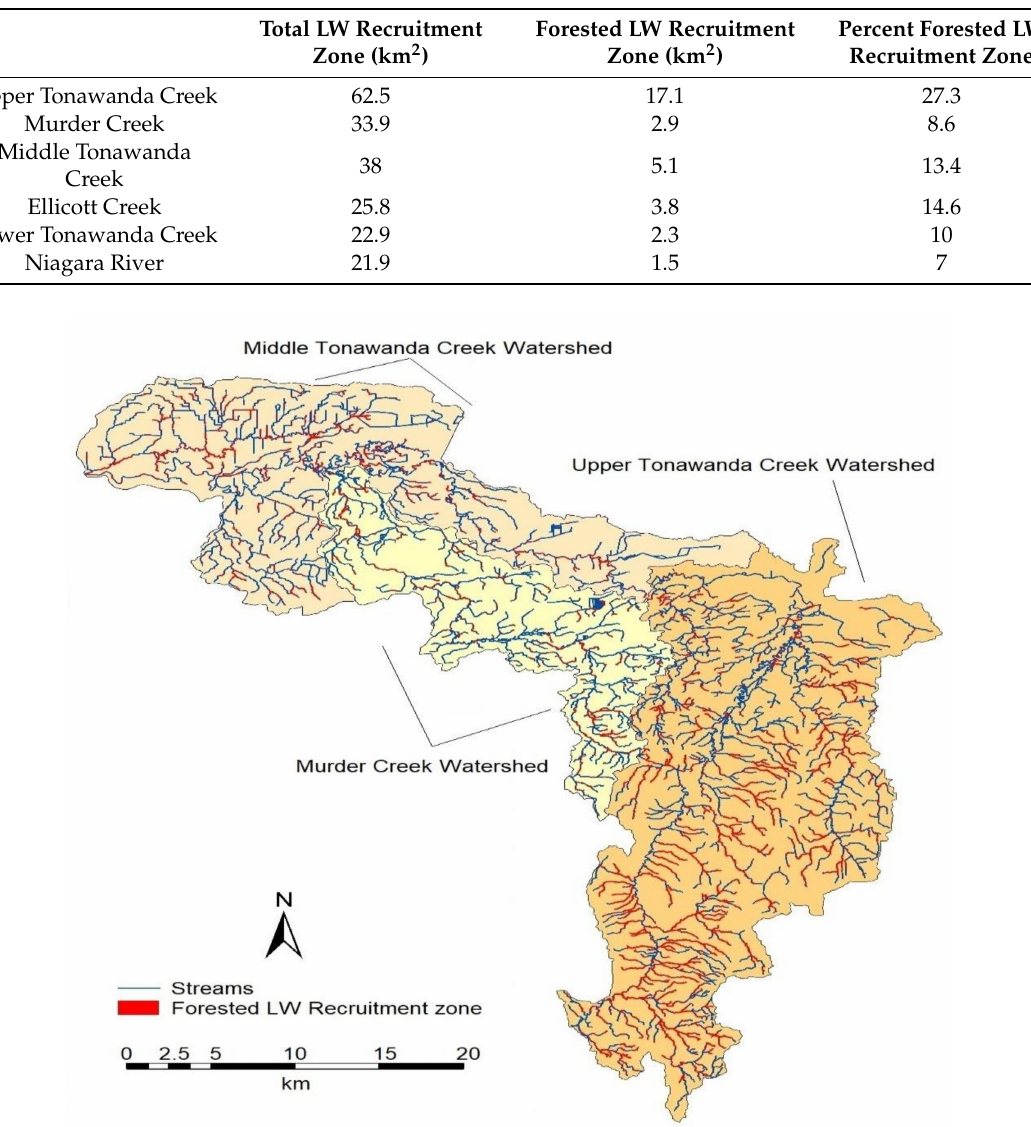
Table 3. Total area (km 2 ) of large wood (LW) recruitment zone (areas within 30 m of stream channel), total area (km 2 ) of forested LW recruitment zone, and percent forested LW recruitment zone for each of the six watersheds of the Niagara Subbasin.